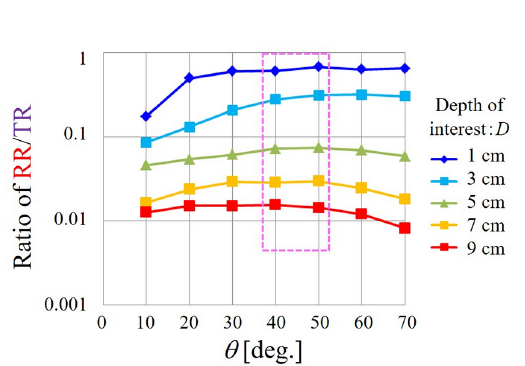
Figure 8 : Ratio of detection rate and total production rate at each depth of interest D for the 1951 keV γ -ray.